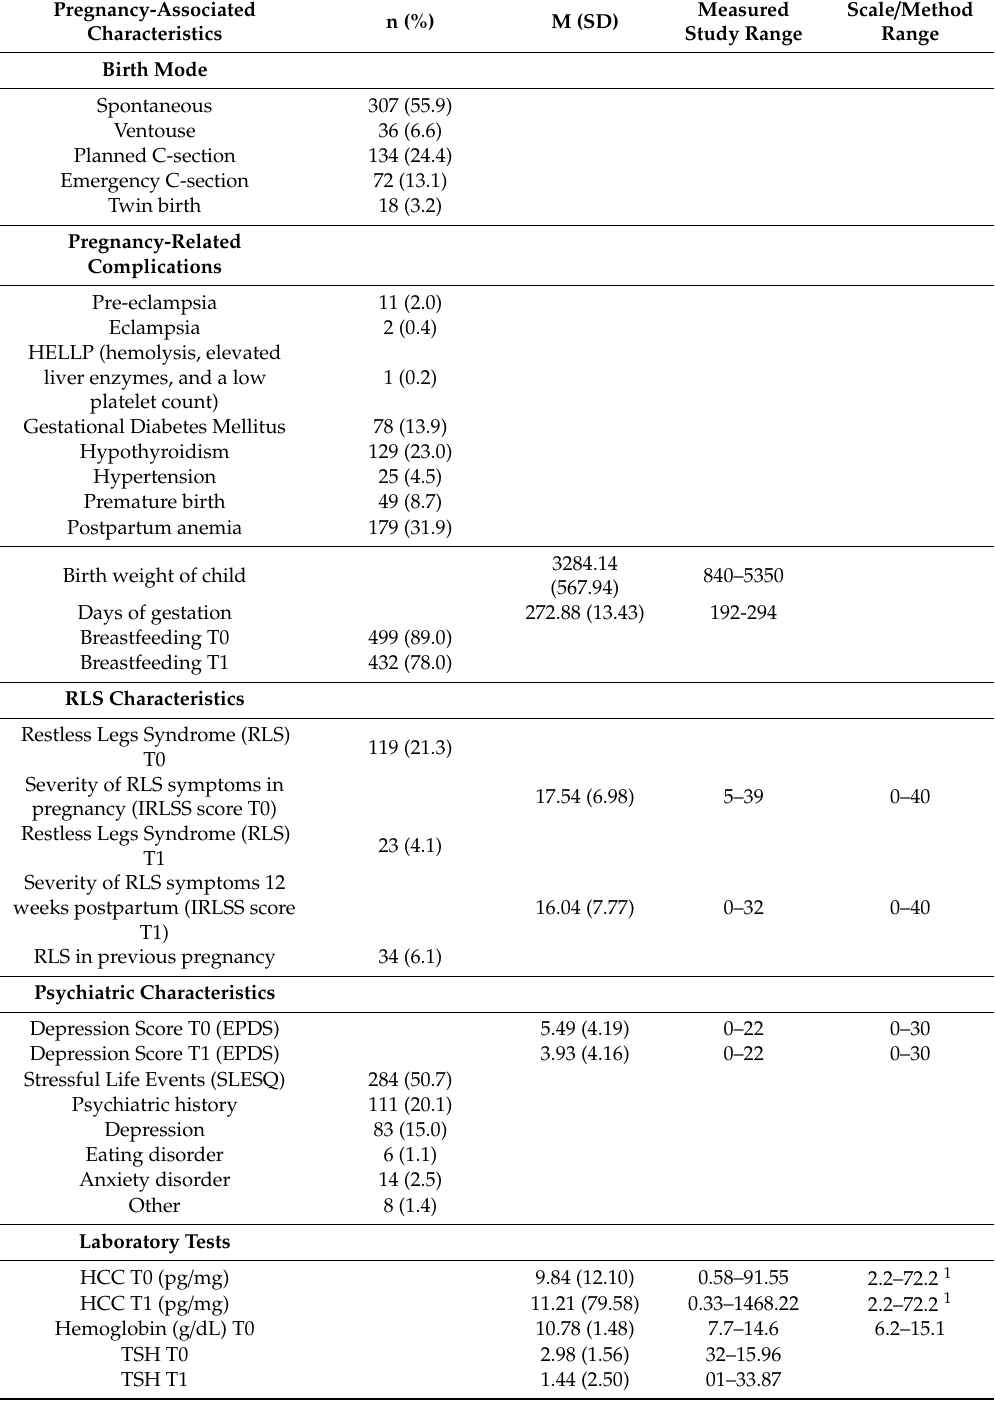
Table A2. Description of the study